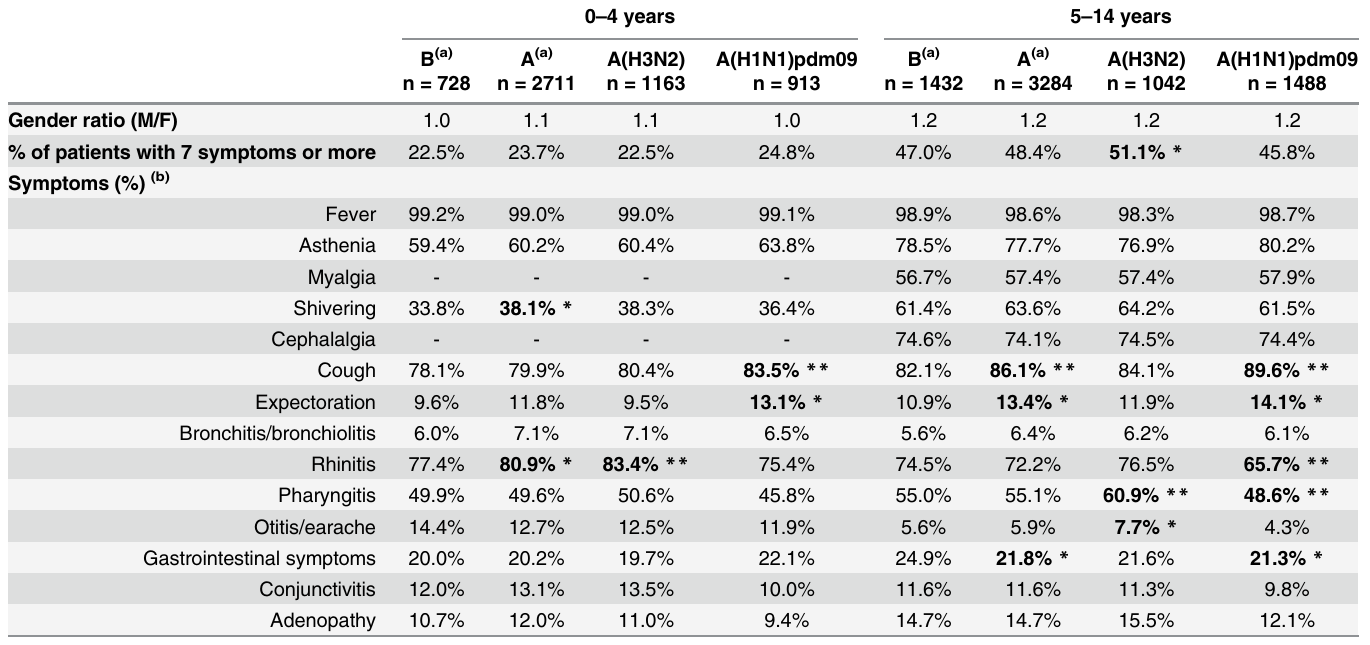
Table 2. Clinical presentation of influenza patients according to age group and influenza virus type and subtype in the age groups 0 – 4 years and 5 – 14 years. Univariate analysis. The IBVD (Influenza B in Vircases database) study, France, 2003 – 2004 to 2012 –